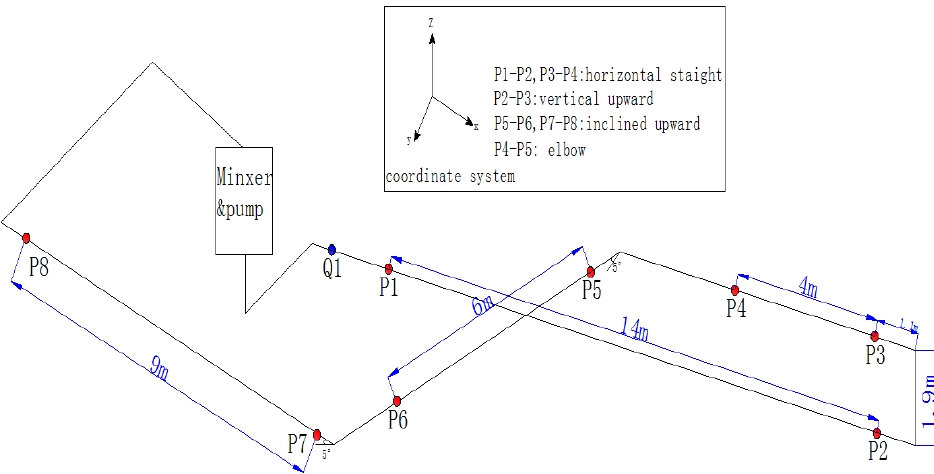
Figure 1. Schematic of the pipe transportation system.